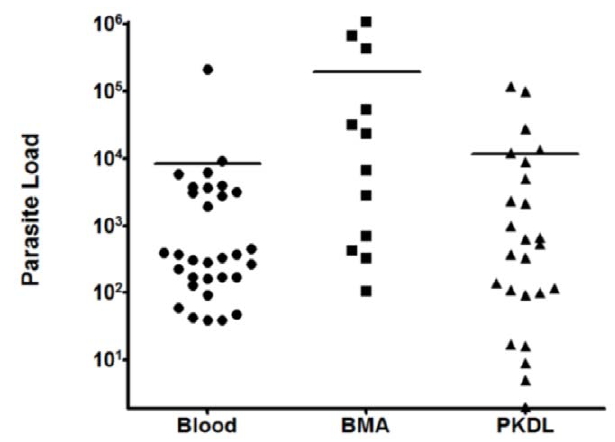
Figure 2. Scatter plot showing parasite load in Blood, BMA and PKDL samples. Parasite load in VL blood samples (Parasites/ml blood) and in BMA samples (Parasites/million nucleated cells) and in PKDL lesion tissues (parasites/ m g tissue DNA) were determined by real-time PCR. Horizontal line represents the mean parasite load.